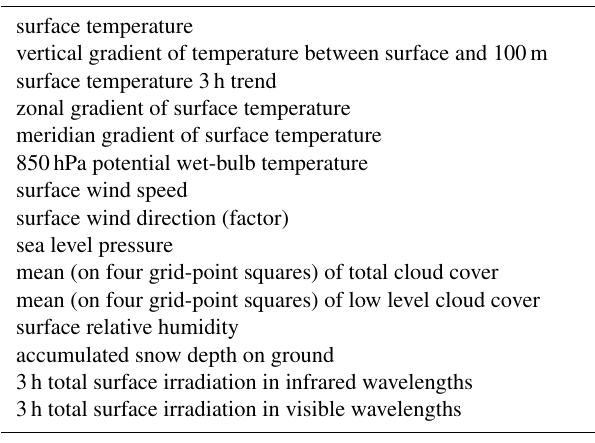
Table 1. Predictors involved in station-based PEARP post- processing. The target variable is surface temperature. From the ARPEGE model (and up to lead time 60/78h for irra- diation